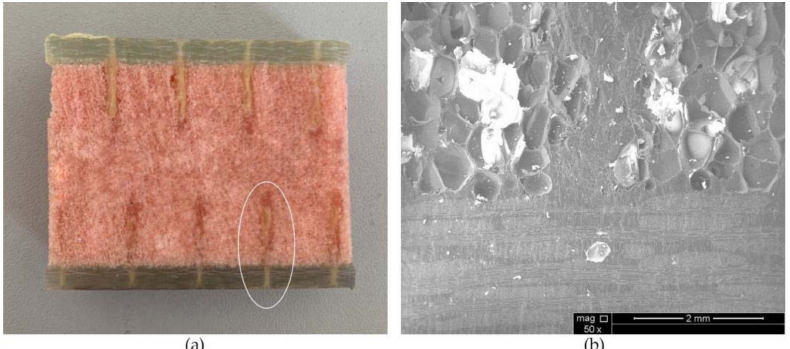
Figure 14. FH-8 specimen. ( a ) Suture profile and ( b ) SEM image of suture profile.